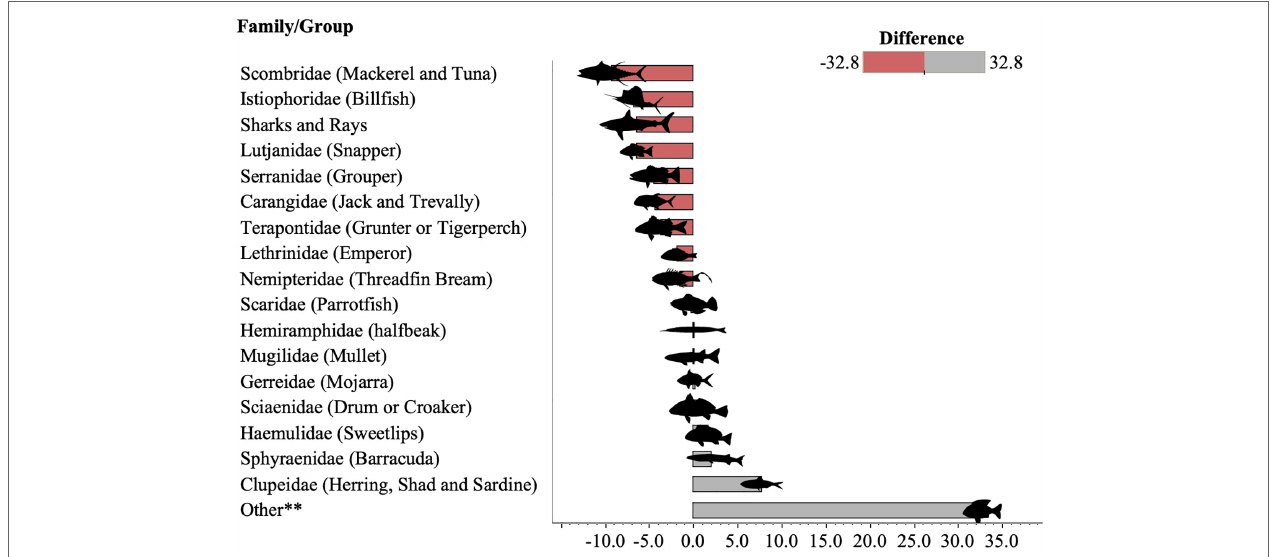
FIGURE 3 | Change in fish family composition between 1991 (Laroche et al., 1997) and 2011 (this study) for all gear types. Red bars indicate fish families that reduced in proportional representation by weight in catches between 1991 and 2011 (e.g. sharks and rays dropped by 6.4% from 11.1% in 1991 to 4.7% in 2011, while Istiophoridae comprised 6.8% in 1991 but was absent from catches in 2011. Those in grey appeared more frequently in catches in 2011 (e.g. Sciaenidae increased by 0.5% from 1.7% in 1991 to 2.2% in 2011). **Other included 19 families in 2011 ( Acanthuridae, Albulidae, Ariidae, Belonidae, Chanidae, Chirocentridae, Congridae, Diodontidae, Echeneidae, Engraulidae, Kyphosidae, Leiognathidae, Lobotidae, Mullidae, Muraenidae, Sillaginidae, and Soleidae, Synodontidae and Trichuridae ). No further information was given on the composition of the group ‘Others’ in Laroche et al. (1997).